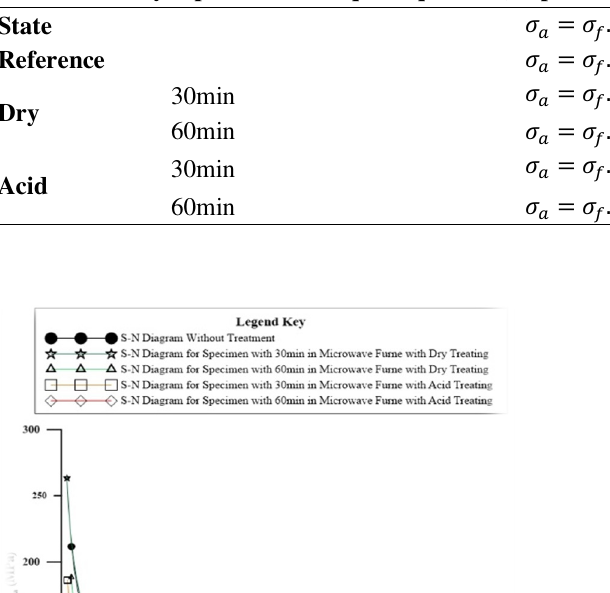
Mathematically represent of Basquin equation (amplitude stress) σ a MPa